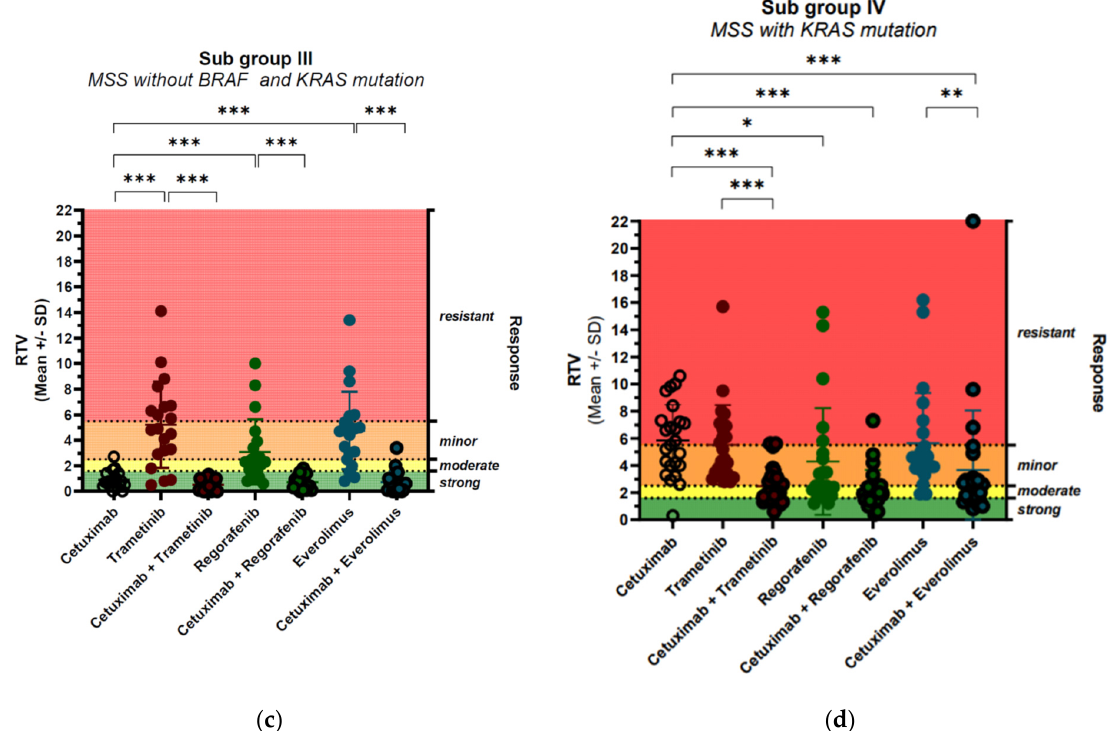
Figure 4. Effects of single treatments in comparison to drug combinations in: Subgroup I with MSI hypermutated colon cancer ( a ), Subgroup II with MSS and BRAF-mutated colon cancer ( b ), Subgroup III with MSS and KRAS and BRAF wild-type colon cancer ( c ), Subgroup IV with MSS and KRAS-mutated colon cancer ( d ) (p values are displayed as follows: p value > 0.05 ns; p value ≤ 0.05 *; p value ≤ 0.01 **; p value ≤ 0.001 ***).